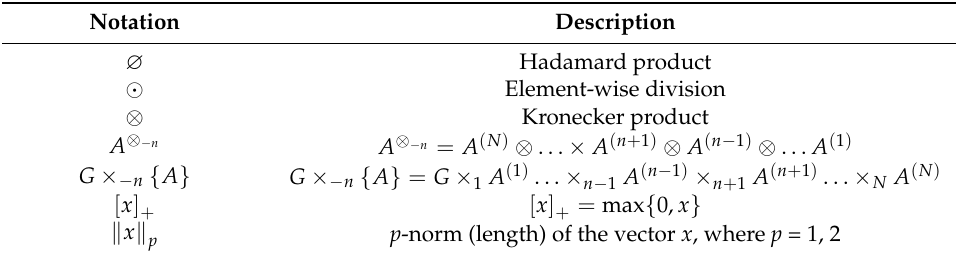
Table 3. Notations of